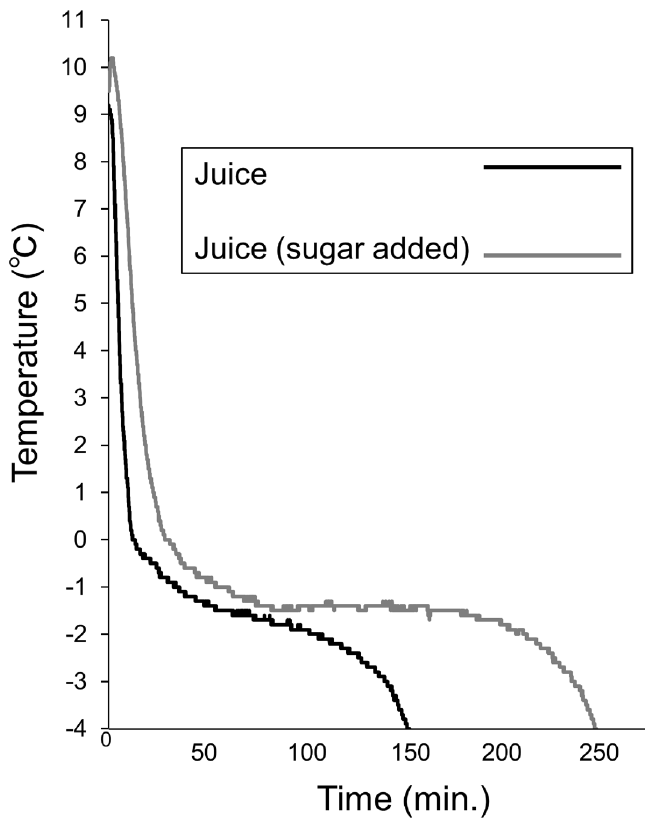
Figure 2. Temperature change for freezing of juice. Temperature changes were measured for normal apple juice (black) and sugar added juice